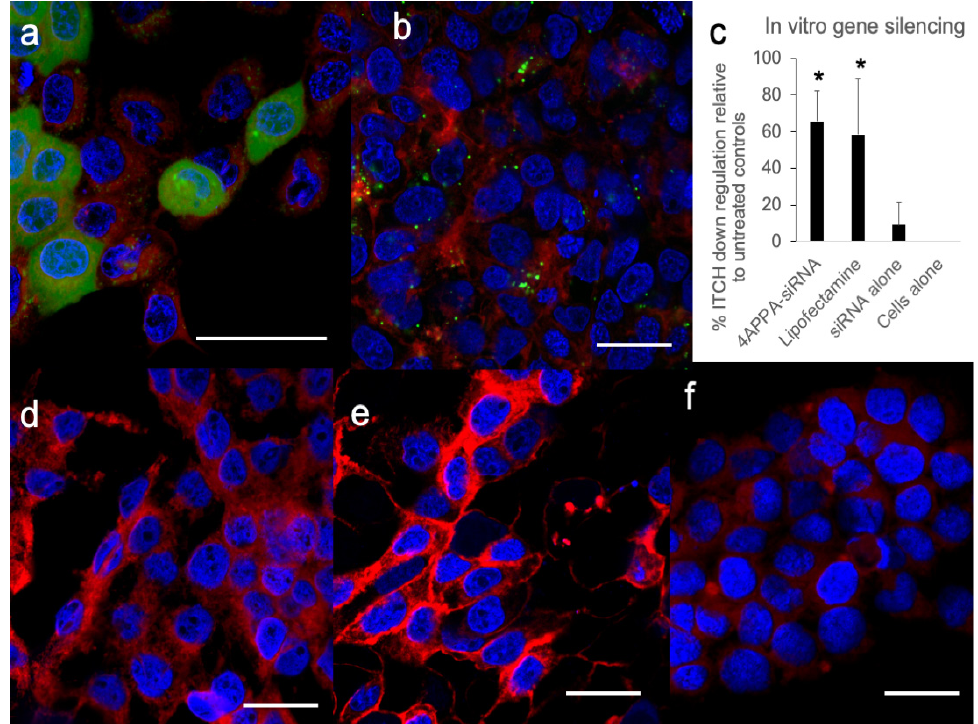
Figure 3. CLSM images ( a , b , d – f ) and in vitro gene silencing using siRNA ( c ) in A431 cells. ( a , b , d – f )—A431 cells (seeded at 150,000 cells per well) with the cell nucleus stained blue (DAPI), cell cytoplasm stained red (CellMask™) and FAM™-siRNA stained green: ( a ) cells were treated with 4APPA-FAM™-siRNA (20 μ g mL − 1 siRNA, 500 μ L) for 6 h, ( b ) cells were treated with Lipofectamine-FAM™-siRNA (100 μ g mL − 1 siRNA, 30 μ L) according to the manufacturer’s instructions, ( d ) cells were treated with PBS, ( e ) cells were treated with FAM™-siRNA alone (20 µ g mL − 1 siRNA, 500 µ L), ( f ) untreated control cells. Bar = 20 µ m. Data showing separate images from the FAM, DAPI and CellMask channels may be found in Figures S3–S7 in the Supplementary Information file. ( c ) Western blot densitometry analysis of ITCH gene silencing showing percentage ITCH down regulation when compared to siRNA alone (mean ± s.d., n = 5 and representative of 3 separate experiments) in A431 cells (seeded at 400,000 cells per flask) incubated for 6 h with 4APPA-siRNA (20 µ g mL − 1 siRNA, 500 µ L, N, P ratio = 32 in phosphate buffer—2 mM, pH = 6.0), Lipofectamine 2000™-siRNA (100 µ g mL − 1 siRNA, 30 µ L) prepared according to the manufacturer’s instructions, siRNA alone (20 µ g mL − 1 siRNA, 500 µ L), Western blot gels may be found in Figure S8 in the Supplementary Information file. * = statistically significant difference p <